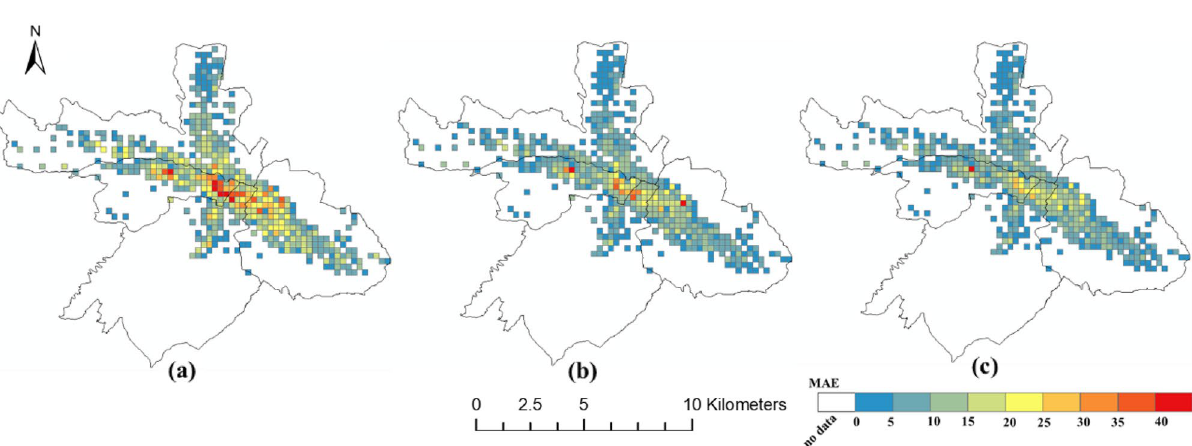
Figure 6. Spatial distributions of the MAEs of different models: ( a ) SVR; ( b ) TGCN; ( c ) FPM-geo.